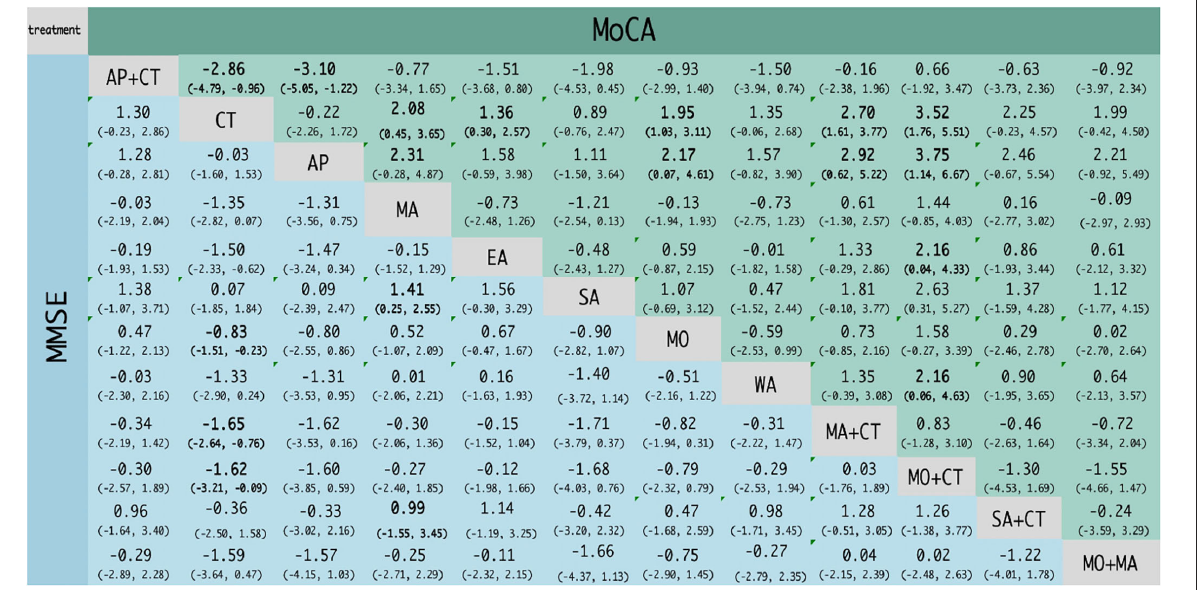
5.49], P > 0.05). The data heterogeneity test ( I 2